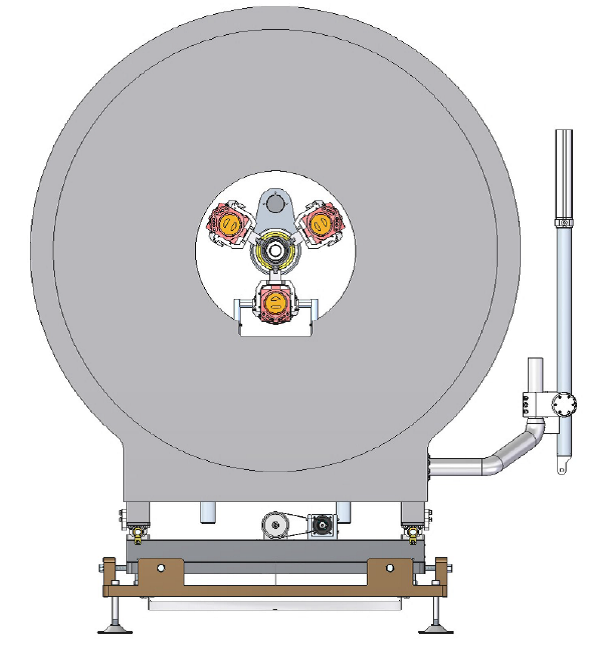
Figure 4. Simplified cross-sectional view of a target station. The robot arm is on the right. The beam axis is perpendicular to the page and points towards the reader.